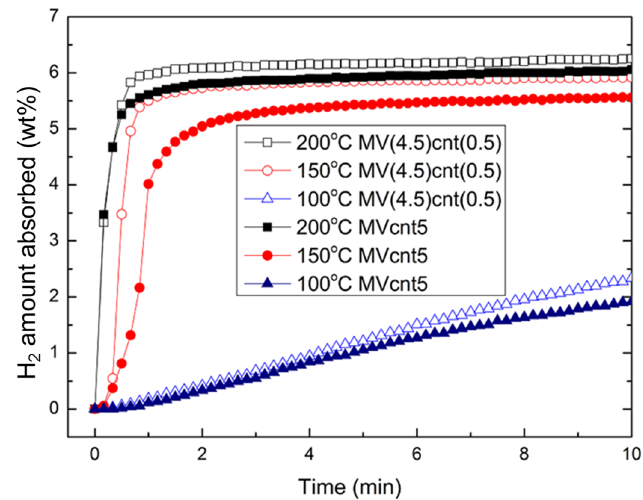
Figure 7. Hydrogen absorption of MVcnt5 and MV(4.5)cnt(0.5) at 200, 150 and 100 °C with an initial pressure of 2.0 MPa, respectively.